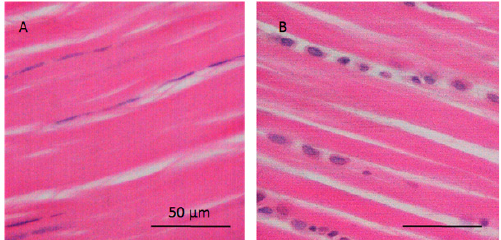
Figure 1. Histological images of the traction and gliding area of tendon. ( A ) Traction region with elongated tenocytes parallel to the collagen fibers and ( B ) gliding area with chondrocyte-like cells at regions of pressure in hypomochlion (tendon of flexor digitorum longus; rat).